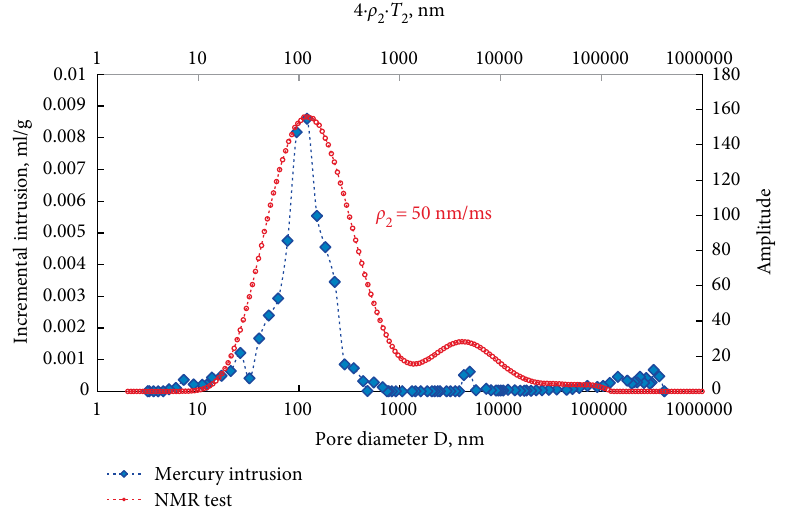
Figure 4: The pore size distribution by mercury intrusion and NMR test.